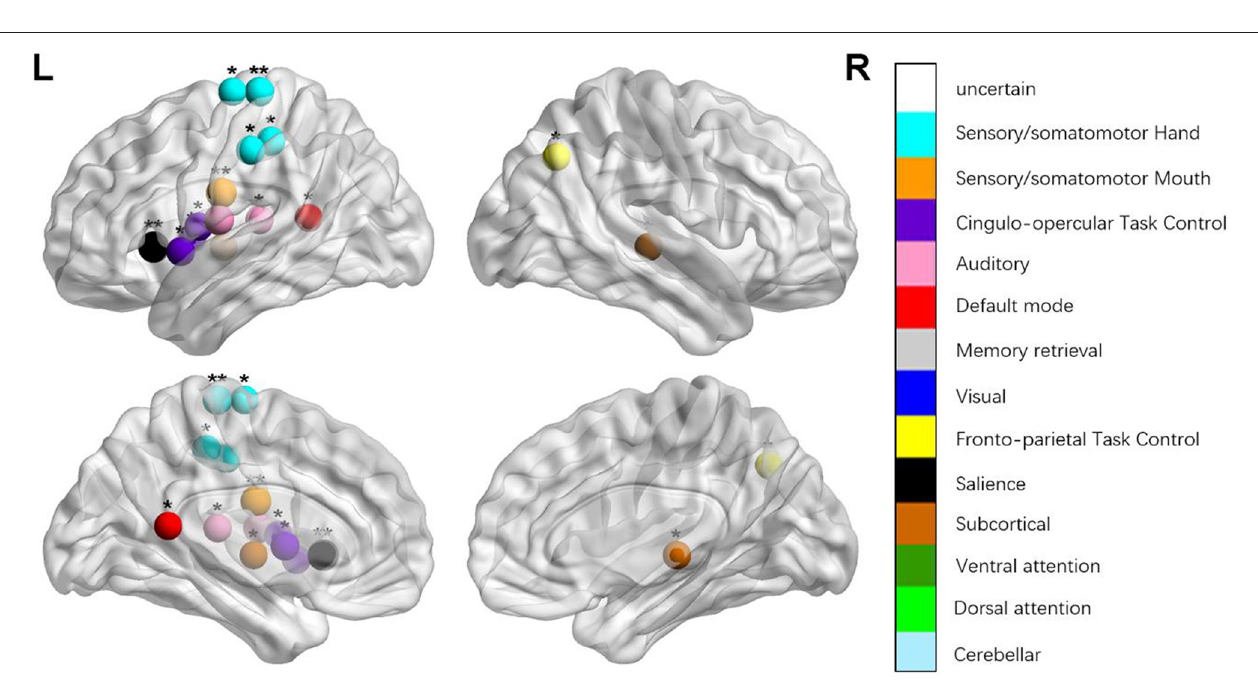
FIGURE 1 | Regions were considered abnormal nodal betweenness in patients with aphasia if they exhibited significant between-group differences. * p < 0.000189, Bonferroni correction (i.e., 1/264).